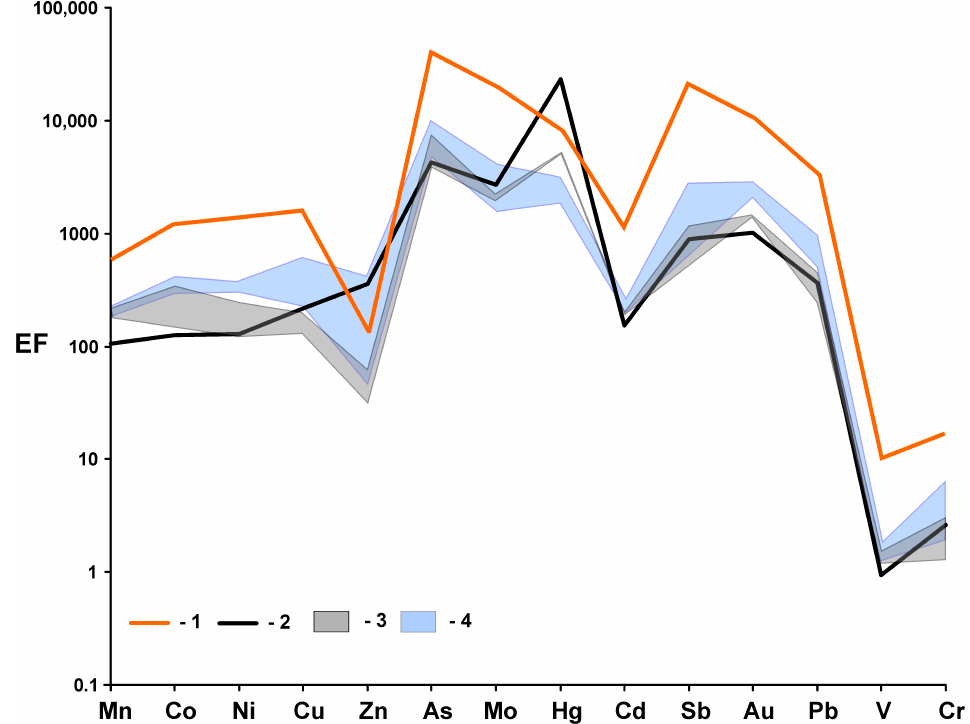
Figure 13. Trace element enrichment of framboidal pyrite and pyrite pseudomorphs after fossil remnants versus large euhedral pyrite crystals. ICP-MS data for bulk fractions (Table 6). Relative enrichment factor EF element = ([C] element /[C] Ga ) sample /([C] element /[C] Ga ) PAAS [45]. PAAS after [75]. 1 = pyrite pseudomorphs after fossil remnants (Andrusov Hill); 2 = large euhedral pyrite crystals (Andrusov Hill); 3 = large euhedral pyrite crystals (Trubetskoy and Tischenko Hills); 4 = framboidal pyrite (Andrusov, Trubetskoy and Tischenko Hills).